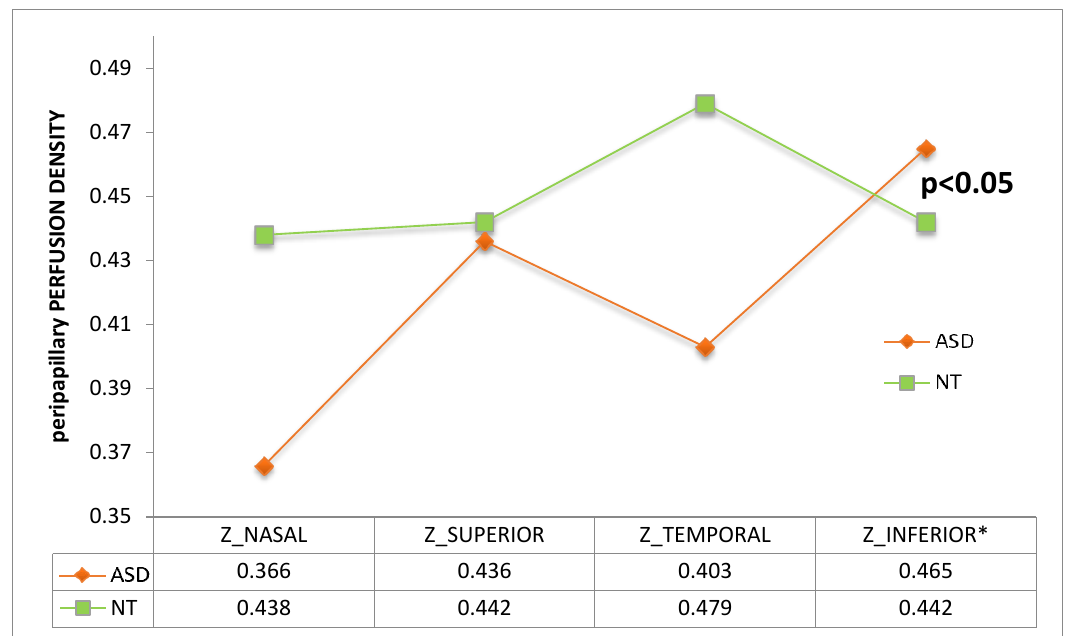
Figure 11. Perfusion density of the 4 peripapillary quadrants. ASD = autism spectrum disorder group; NT = neurotypical group. Mean values were indicated for each group. * Note that the difference between inferior values is statistically significant ( p = 0.029, Mann–Whitney U test). T = temporal, S = superior, N = nasal, I = inferior.